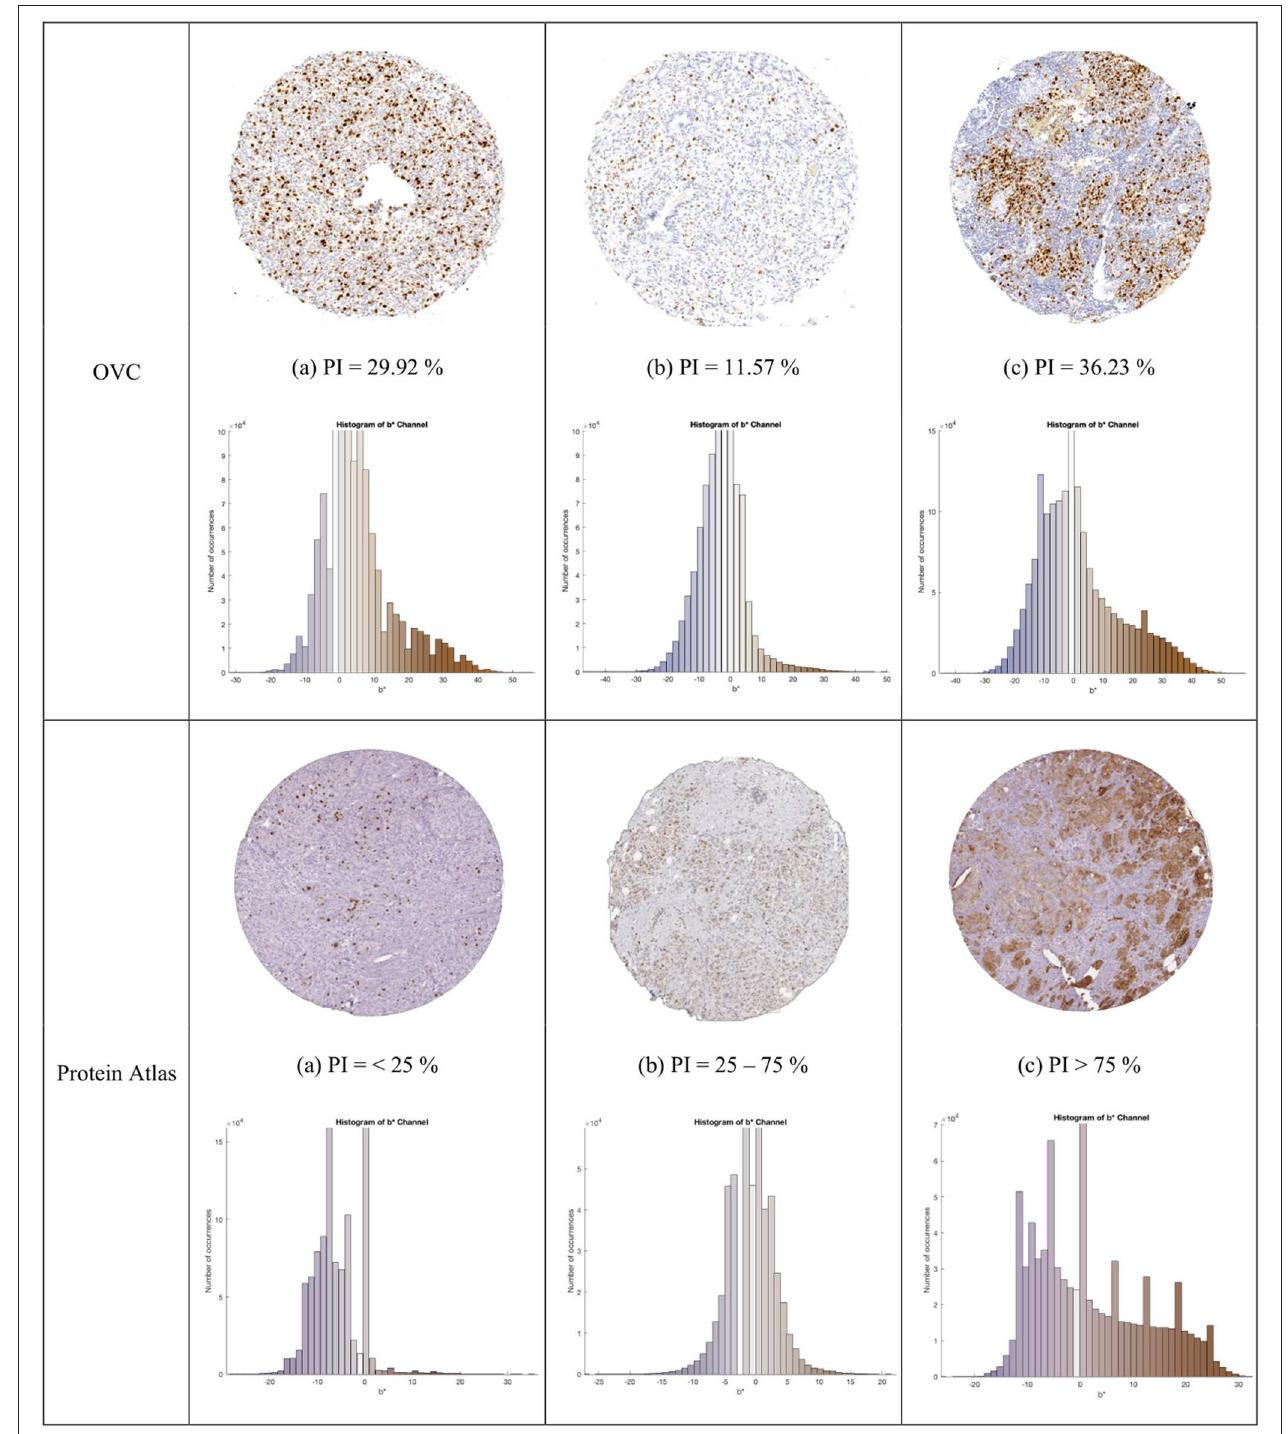
FIGURE 4 | TMA images from OVC ( top ) and Protein Atlas ( middle ) datasets, with corresponding IHCCH below.